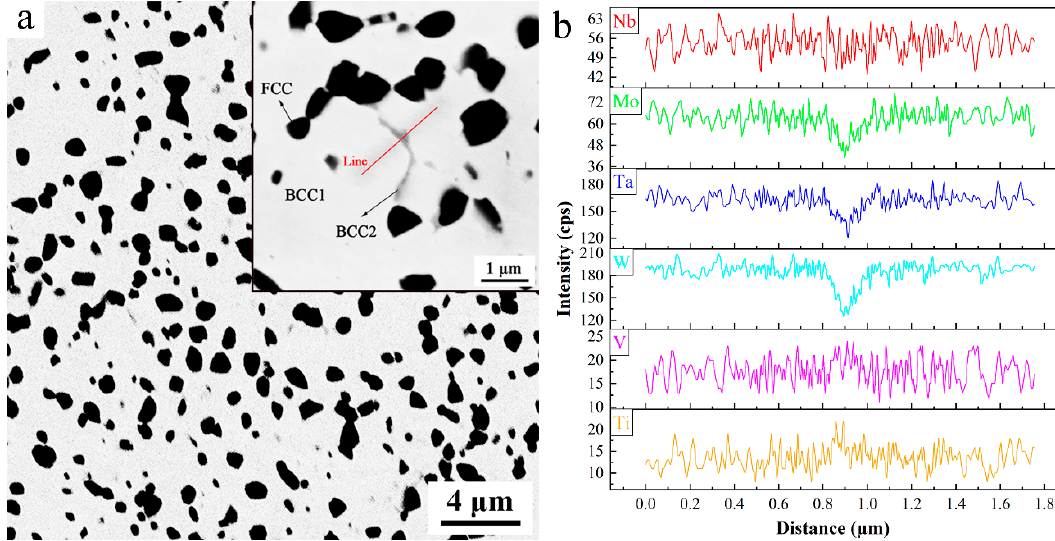
Figure 2. ( a ) SEM back scatter electron images of the bulk NbMoTaWVTi HEA at different magnifications and ( b ) Elemental composition gradients along the red drawn line. Table 1. Chemical composition (in atom %) analysis results of white matrix phase (BCC1) and black precipitated phase (FCC) in Figure 2 by EDS/SEM.